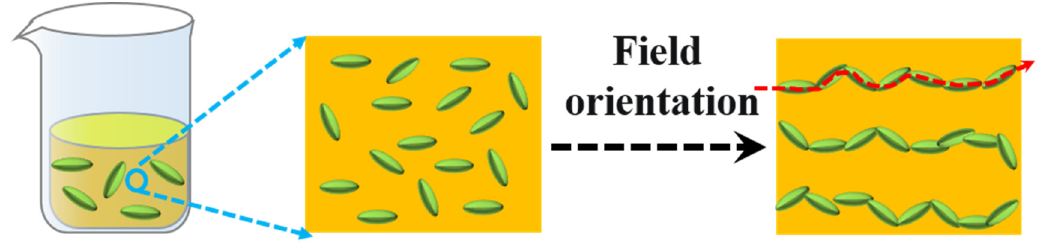
Figure 2. Fillers oriented under external electric fields.